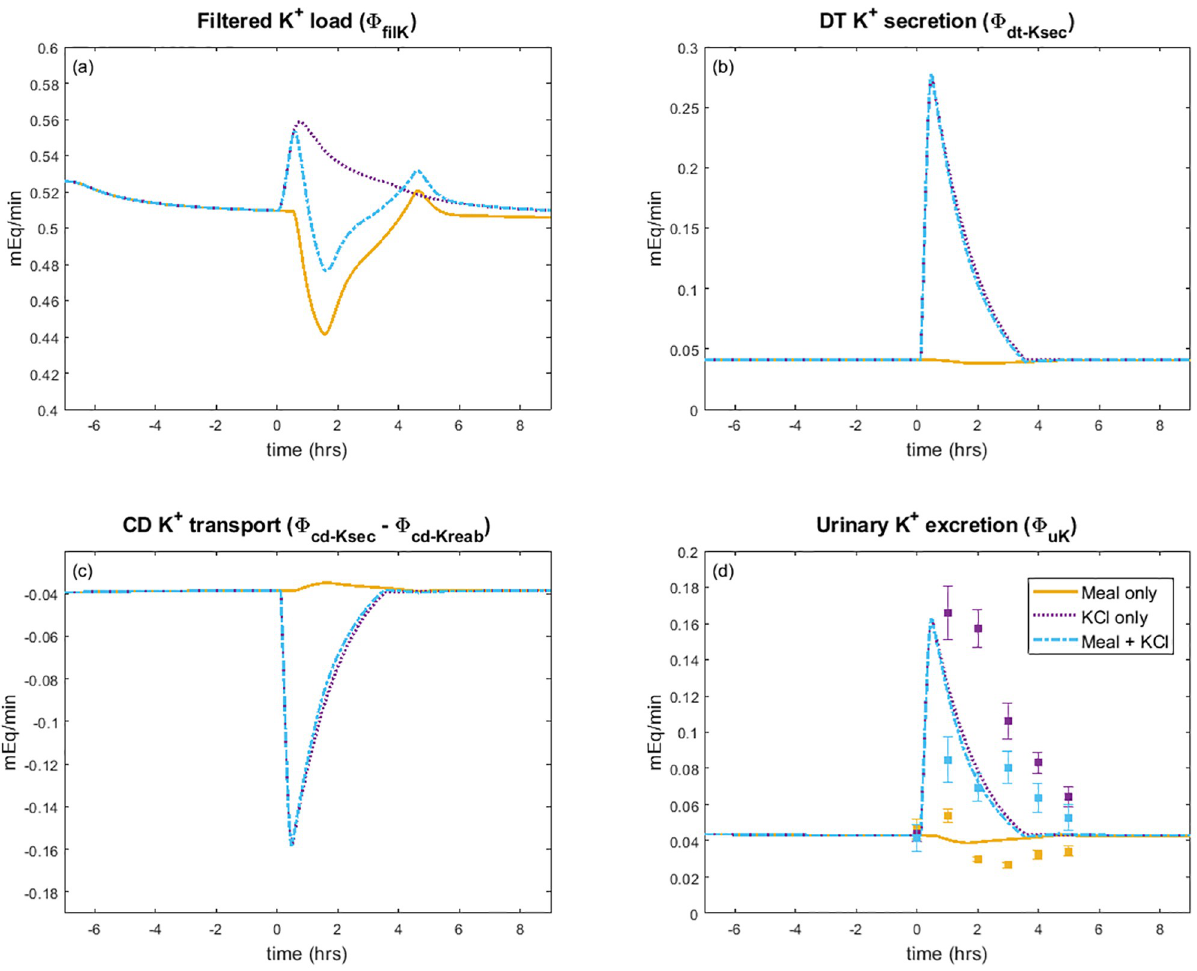
Fig 5. Renal K + response to a single meal. Model simulation predictions for kidney K + handling during a single meal load. The meal experiment occurs at time = 0 hours. Initial conditions are the baseline steady state values (see Table 2) with a fasting state before the meal experiment. The yellow lines denote the K + deficient meal (i.e., “Meal only” experiment); purple, only K + ingestion (i.e., “KCl only” experiment); blue, meal with K + (i.e., “Meal + KCl” experiment). Points and error bars for urine K + excretion show experimental data from Preston et al.